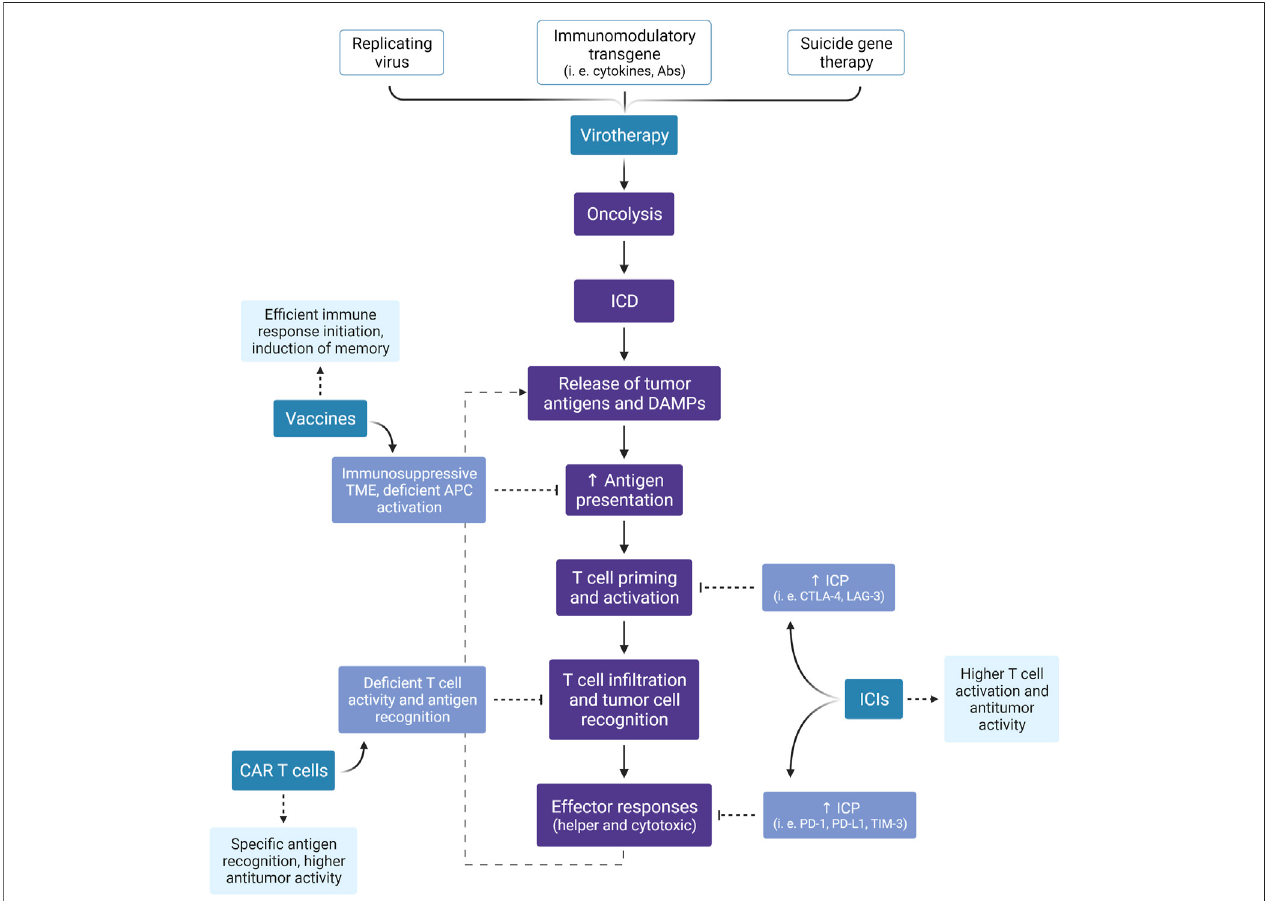
FIGURE 5 | Expected bene fi ts of combined immunotherapies. Besides the direct antitumor effect of virotherapy, especially by the lytic effect of oncolytic viruses, this treatment modality can induce an anti-cancer immune response through the promotion of ICD. Here, we summarize the events illustrated in Figures 3 , 4 and highlight the expected advantage when combining virotherapy with other immunotherapy strategies. ICD, Immunogenic Cell Death; DAMPs, Damage-Associated MolecularPatterns;TME,TumorMicroenvironment;APC,Antigen-PresentingCell;ICP,ImmuneCheckpoint;ICI,ImmuneCheckpointInhibitor;CTLA-4,Cytotoxic T-Lymphocyte-Associated protein 4;LAG-3,Lymphocyte-ActivationGene3; PD-1,Programmedcell Deathprotein 1; PD-L1, ProgrammedcellDeathLigand 1; TIM-3, T cell Immunoglobulin and Mucin domain-containing protein 3; CAR, Chimeric Antigen Receptor. Created with BioRender.com.